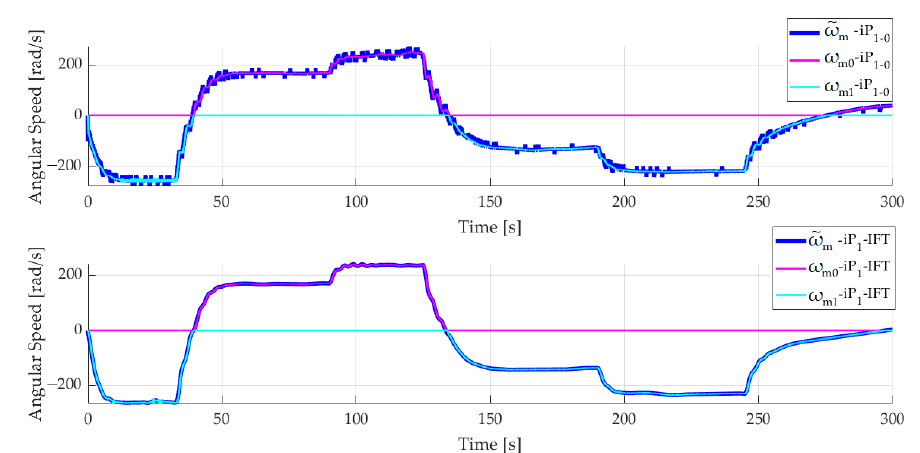
Figure 7. Control signals of iP 1-0 and iP 1 -IFT controllers and the controlled angular speeds for the pitch angle variation experiments.